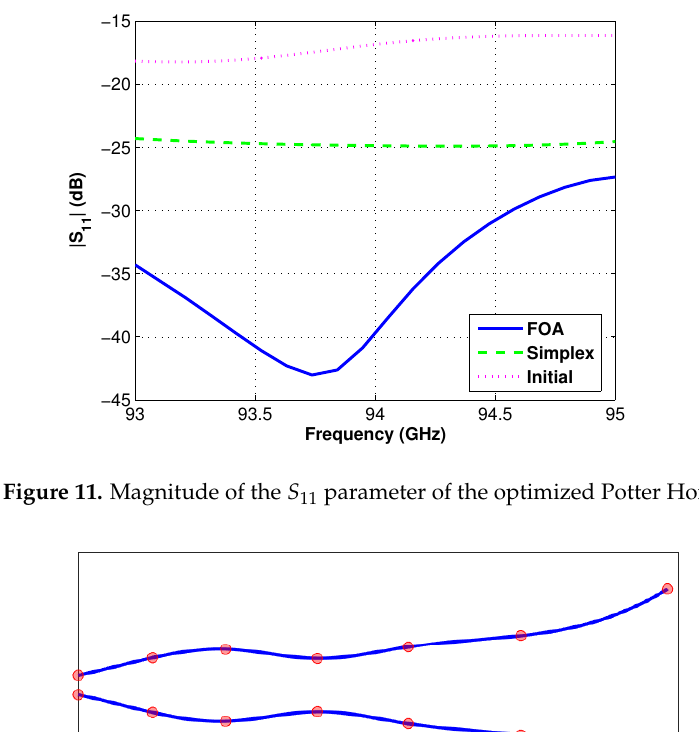
Figure 10. Normalized radiation pattern at 94 GHz of the of the optimized Potter Horn (Diagonal Plane, Crosspolar Component).